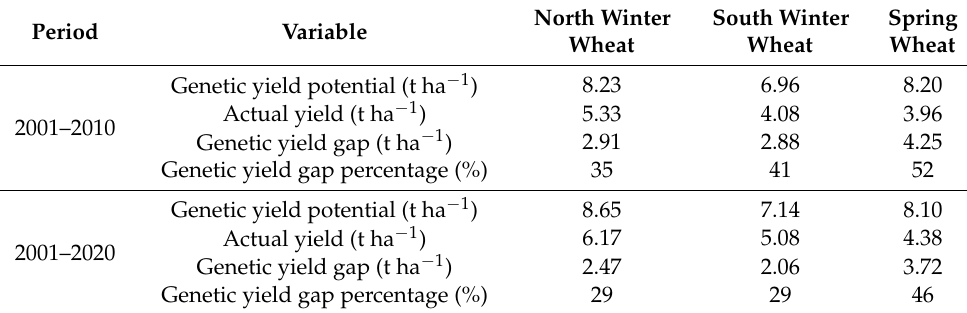
Table 3. Genetic yield potential and genetic yield gap of